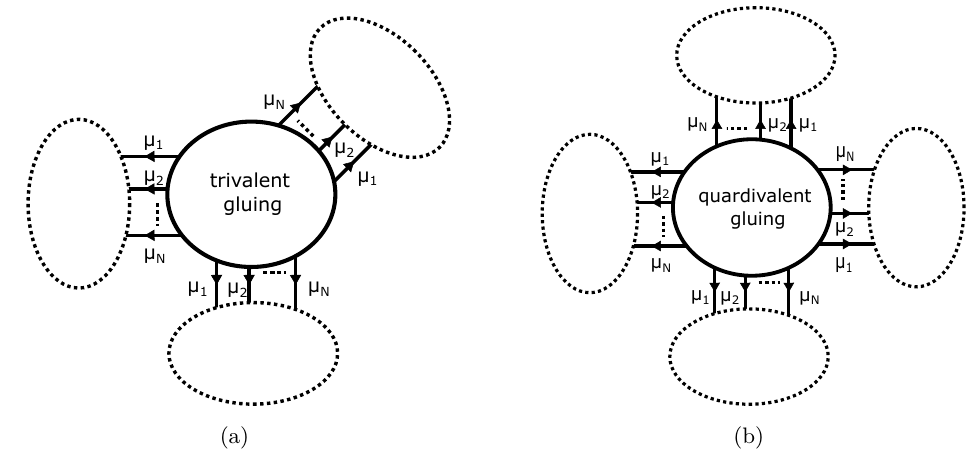
Figure 60. (a): A schematic drawing of the SU( N ) trivalent gauging. (b): A schematic drawing of the SU( N ) quadrivalent gauging.